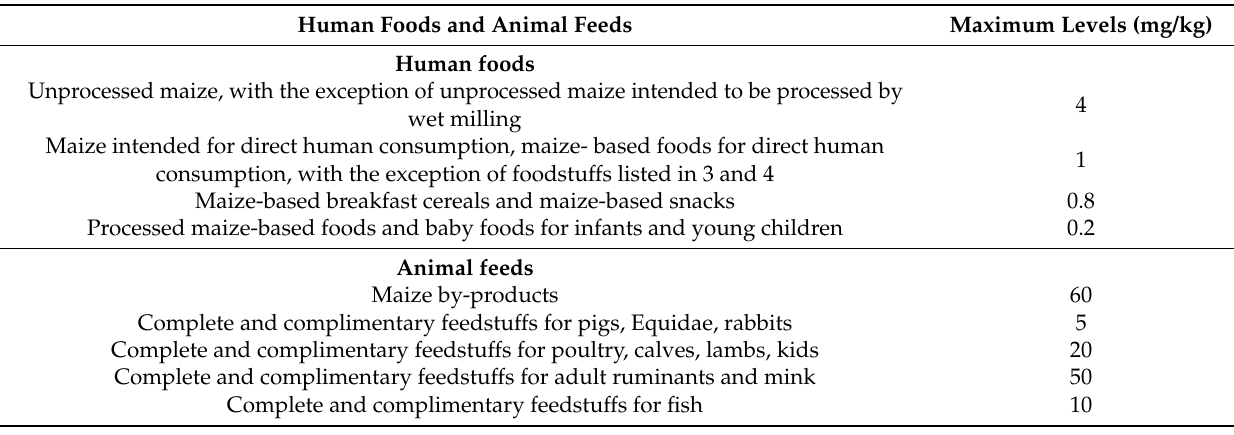
Table 2. EC and EU maximum limits for fumonisins (FB1 + FB2) in human foods and animal